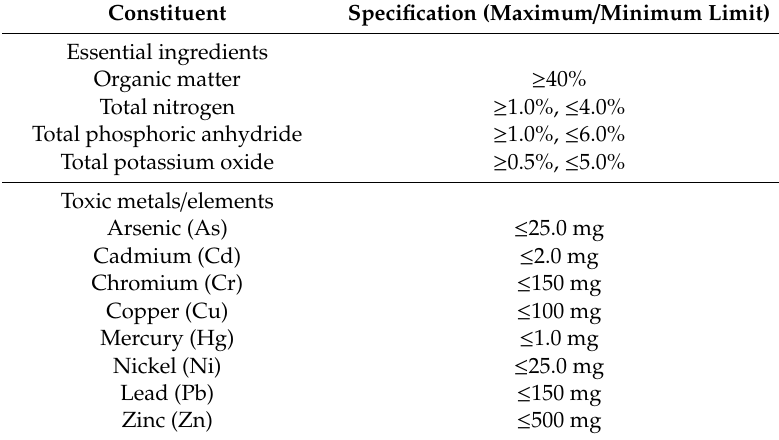
Table 3. Composition specifications for organic fertilizers derived from livestock manure in